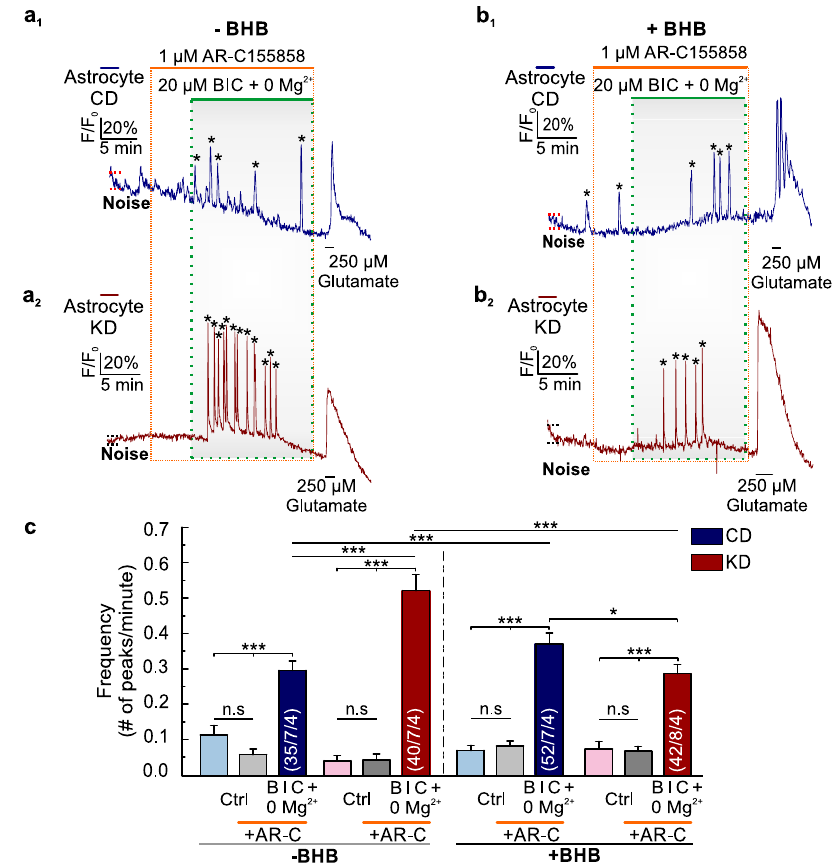
Figure 6. Inhibition of MCT1 and MCT2 in cortical slices decreases epileptiform activity in control mice, while this inhibition increases epileptiform activity in ketogenic mice. Changes in astrocytic Ca 2 + signals, as induced by epileptiform activity (dotted green boxes) in cortical slices in the presence of 1 µ M of AR-C155858 (dashed orange boxes) from control (dark blue traces) and ketogenic (wine red traces) mice in CO 2 /HCO 3 − -buffered solution, in the absence ( a 1 and a 2 ) and the presence ( b 1 and b 2 ) of BHB. One short pulse of 250 µ M L-glutamate was given at the end to verify astrocytic calcium response. ( c ) Frequency of the peaks occurred spontaneously in the absence (light blue and light red bars) and the presence of AR-C155858 (light and dark grey bars), and induced by 0 Mg 2 + /BIC (dark blue and wine red bars) in CO 2 /HCO 3 − -buffer, in the absence and the presence of